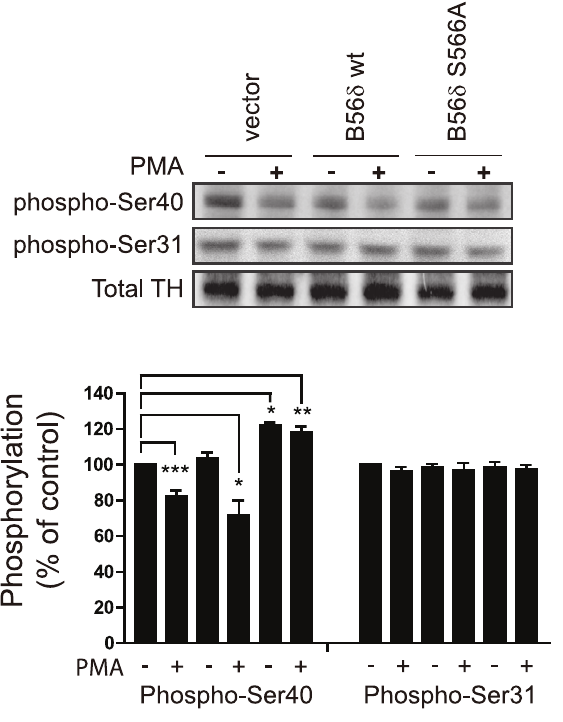
Figure 4. Phosphorylation of B56 d at Ser566 mediates PMA- dependent dephosphorylation of Ser40 of tyrosine hydroxy- lase. N27 cells expressing either vector, FLAG-B56 d wt or FLAG-B56 d S566A mutant were treated with either DMSO (-) or PMA (10 nM) for 30 min. Cells were lysed and proteins were analyzed by SDS-PAGE and immunoblotting with phospho-specific antibodies to Ser40 and Ser31 in tyrosine hydroxylase (TH), and a total tyrosine hydroxylase antibody (upper panels). The bar graph shows quantification of the immunoblot data normalized in each experiment to control as means 6 s.e.m. (n=3). *, P , 0.001, **P , 0.01, ***P , 0.05 compared with vehicle-treated vector control by one-way ANOVA with Newman-Keuls multiple comparison test.